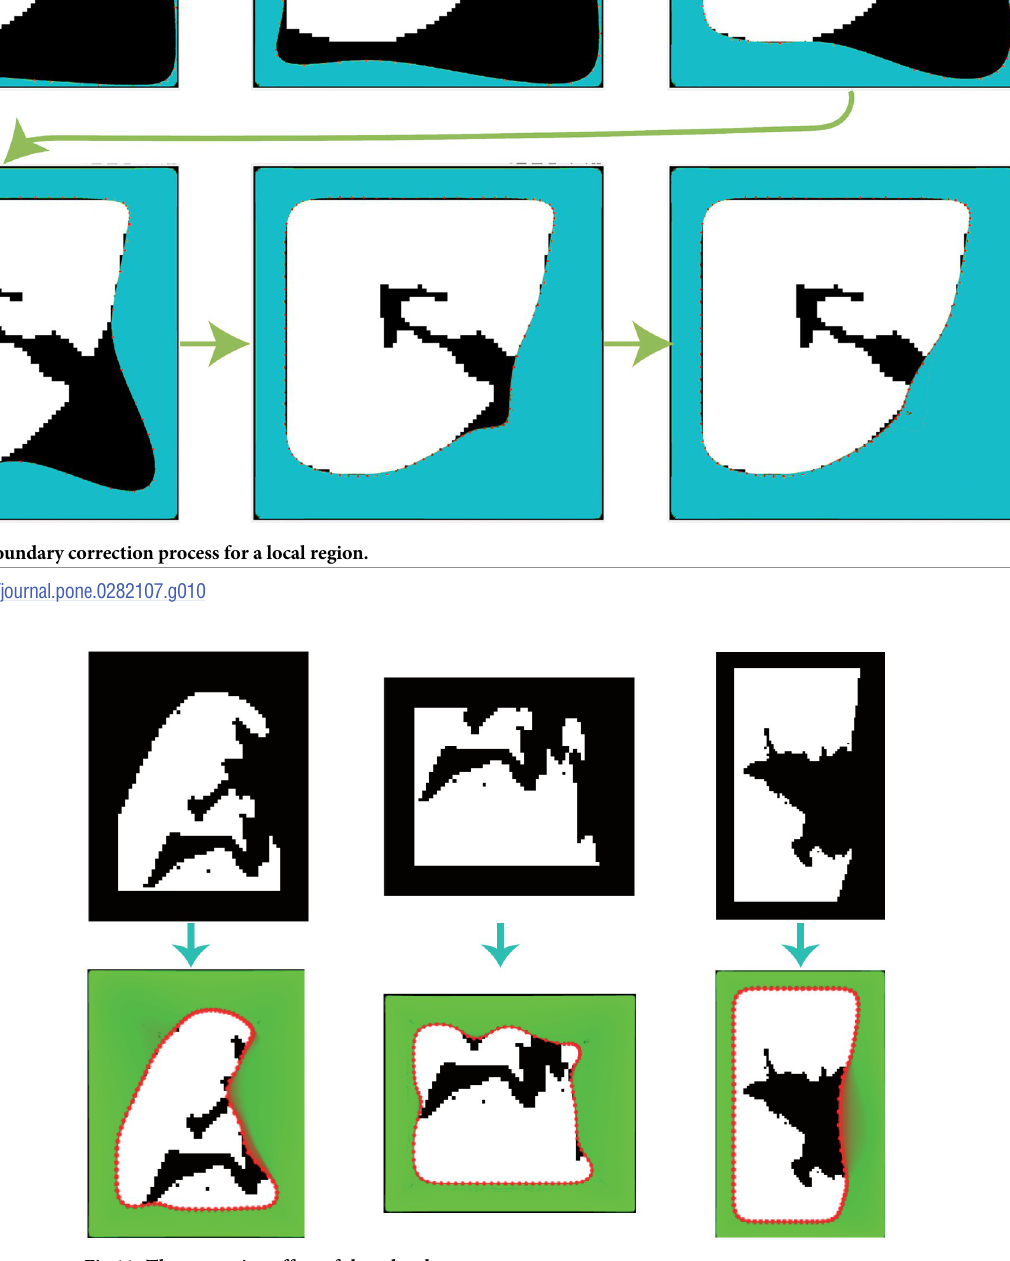
PLOS ONE | https://doi.org/10.1371/journal.pone.0282107 February 28,